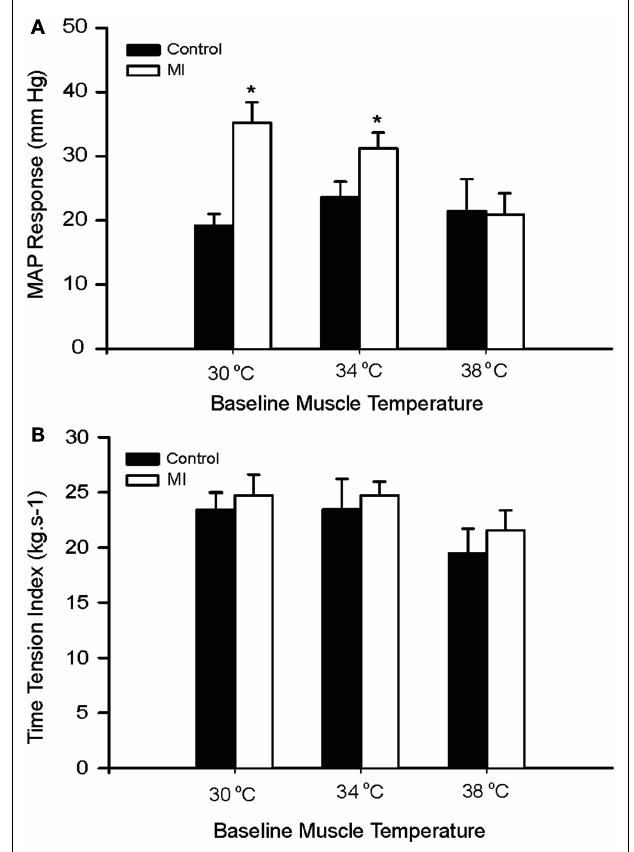
FIGURE 2 | Peak pressor response and developed muscle tension evoked by sciatic nerve stimulation at three different basal T m : 30, 34, and 38˚C in control and MI rats. (A) MAP responses were significantly augmented during static muscle contraction in MI group at baseline T m of 30 and 34˚C. (B) Developed tensions are indicated by time-tension index (TTI), and theTTI induced by static contraction were similar in two groups. * P < 0.05, compared with healthy control group.The number of rats = 9 in control; and 10 in